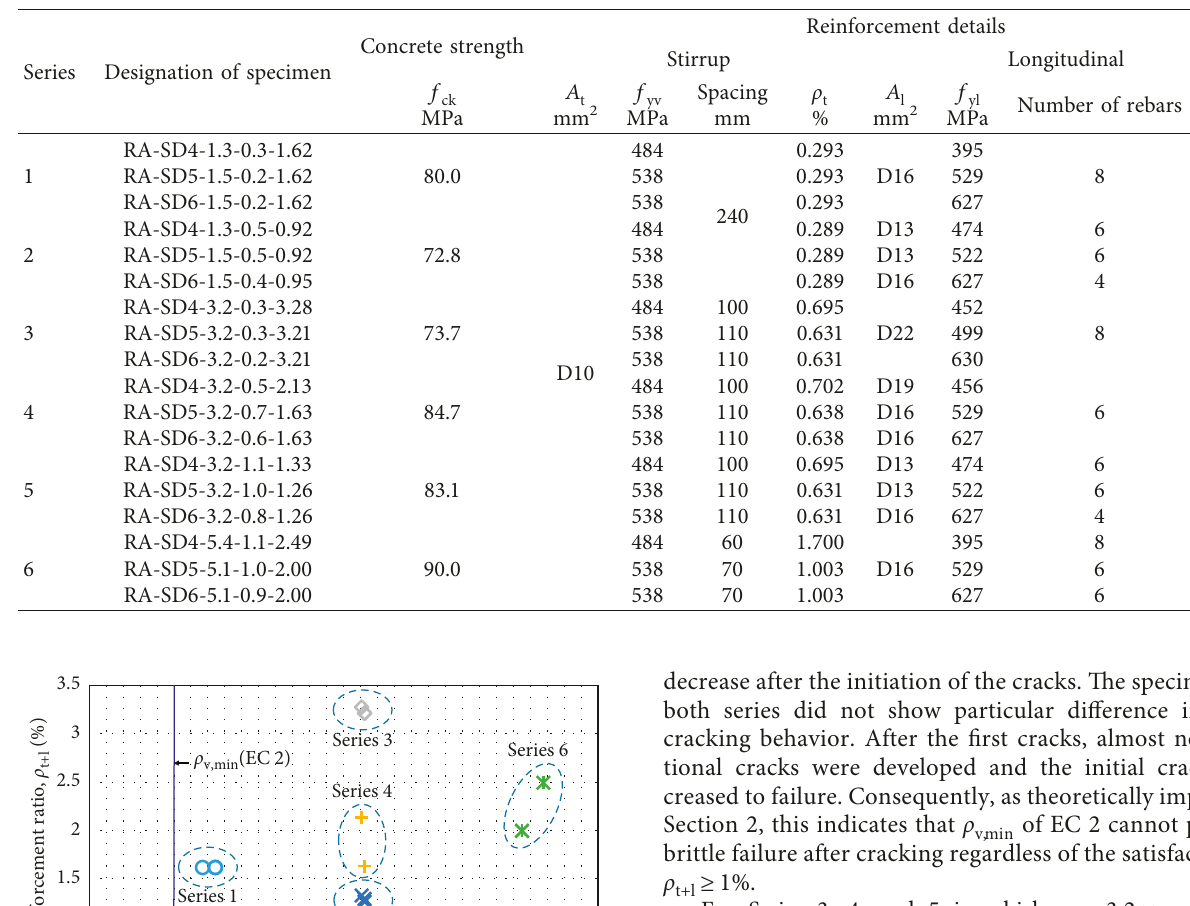
Table 4: Designation and reinforcement details of